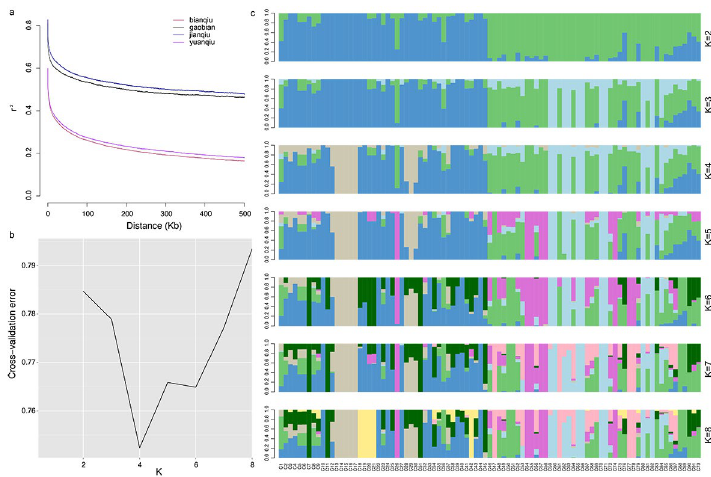
Figure 2. Linkage disequilibrium (LD) and population structure analysis of the 91 B. oleracea acces- sions using SNPs. ( a ) Linkage disequilibrium decay plot of the four leaf ball shapes of B. oleracea . ( b ) The CV (cross validation) errors of different cluster numbers (k = 2 to 8) and the K value cor- responding to the lowest point were used to determine the optimal number of population struc- ture. ( c ) Model-based clustering analysis with cluster numbers from k = 2 to 8. The y -axis indicates the ancestry ratio of each B . oleracea accession, and the x -axis shows the accession number of B. oleracea .